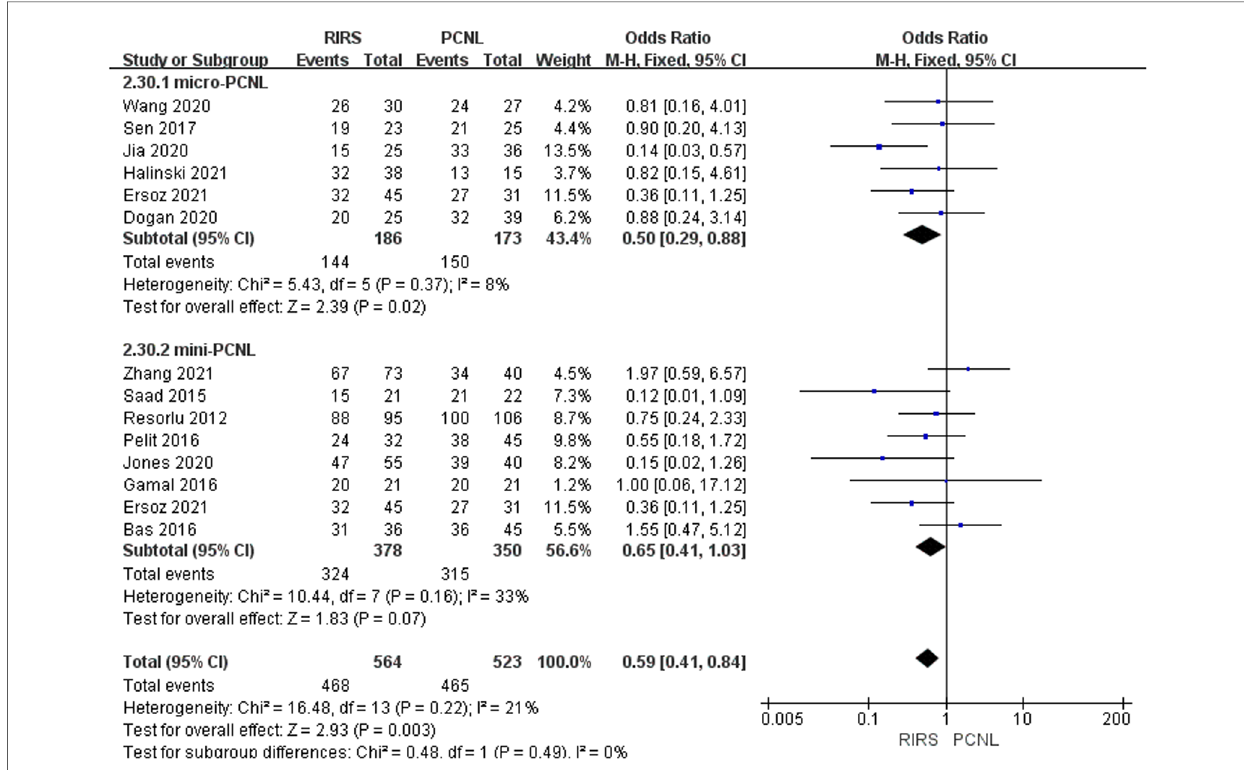
FIGURE 2 Forest plot of stone-free rate in the RIRS group and the PCNL group.